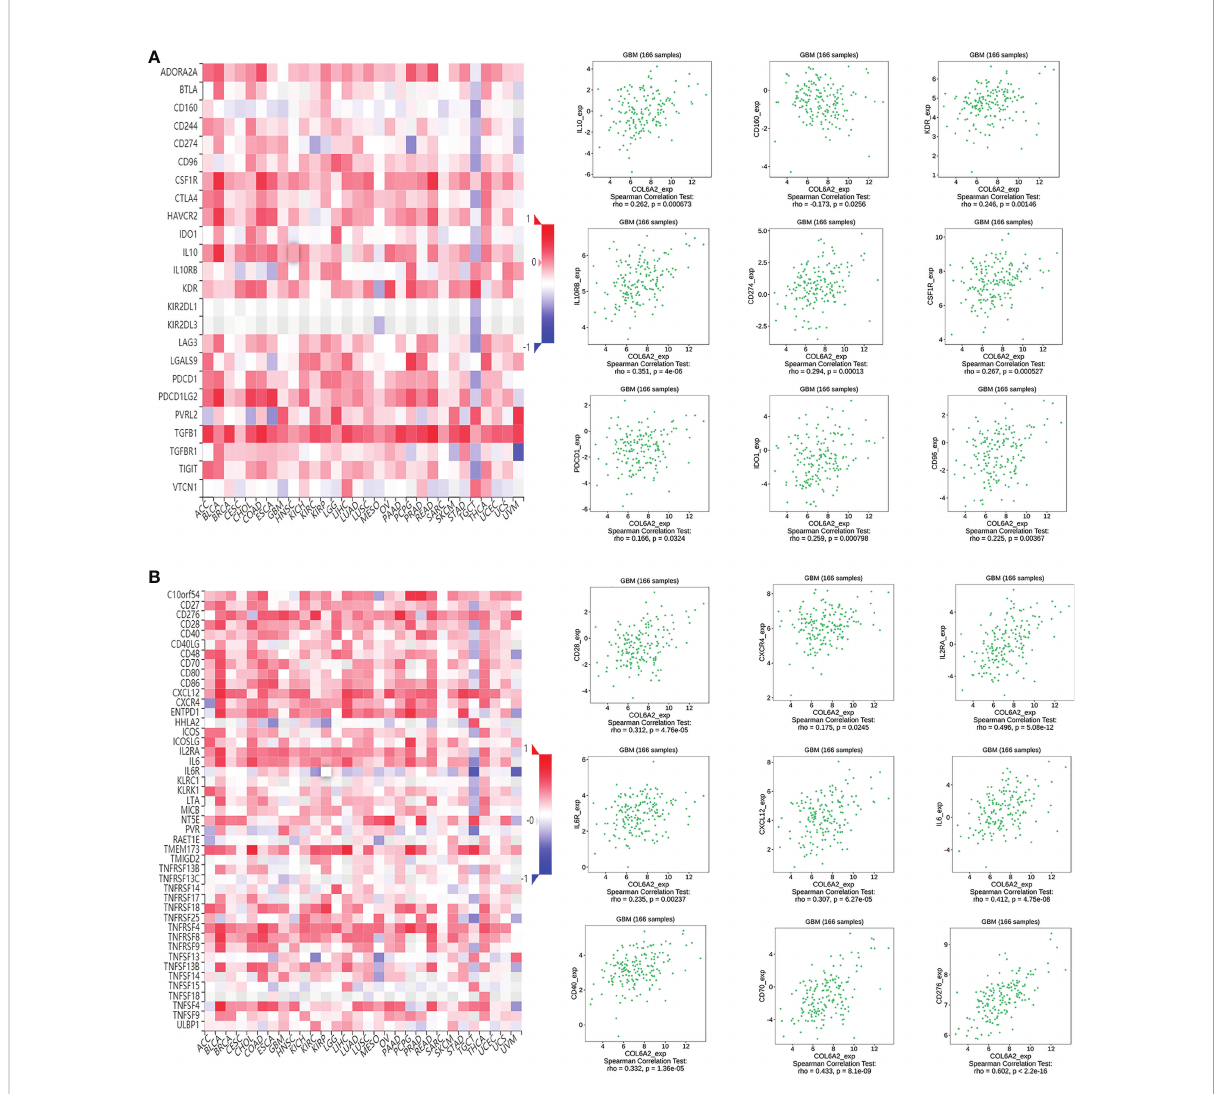
FIGURE 11 COL6A2 expression is associated to immunomodulatory genes. (A) Among immunoinhibitor genes, COL6A2 expression has both positive and negative correlations with IL10, CD160, KDR and other genes in GBM. (B) COL6A2 expression has both positive and negative correlations with CD28, CXCR4, IL2RA and other immunostimulatory genes in GBM. GBM,